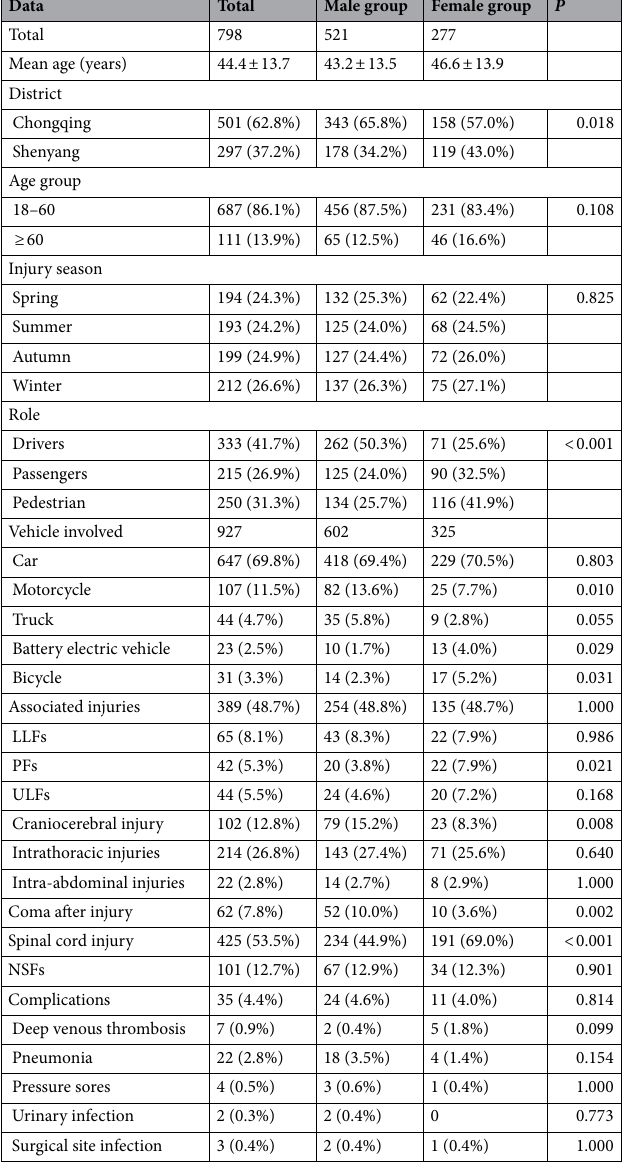
Table 1. Sex differences in TSFs caused by